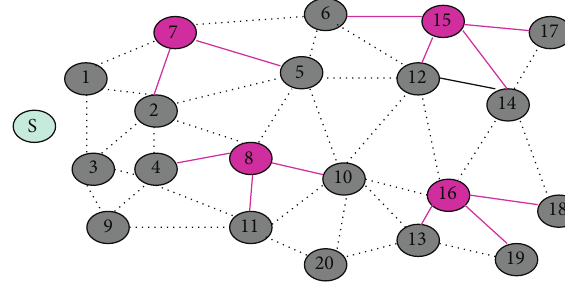
Figure 2: Phase 1: selection of child nodes.